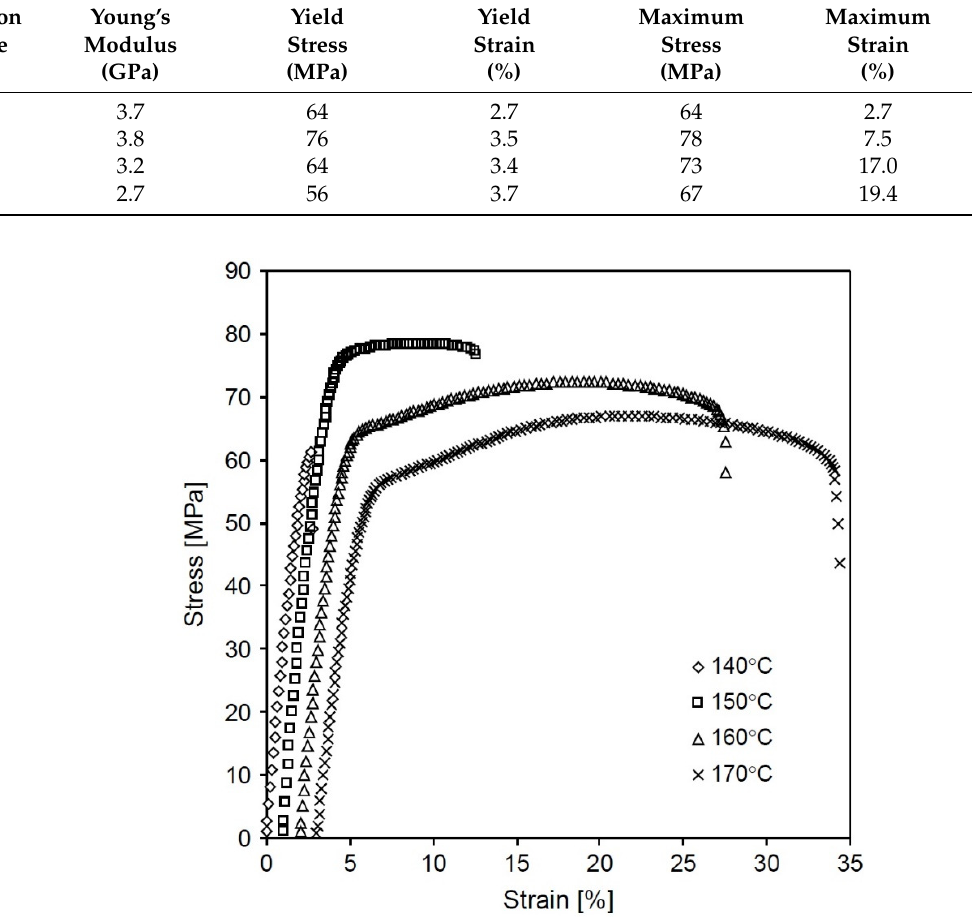
Figure 7. Typical stress–strain curves at various polymerization temperatures for dry as-molded (DAM) APA-6 (curves shifted to the right for clarity). Reprinted from Reference [10], under open- access license.